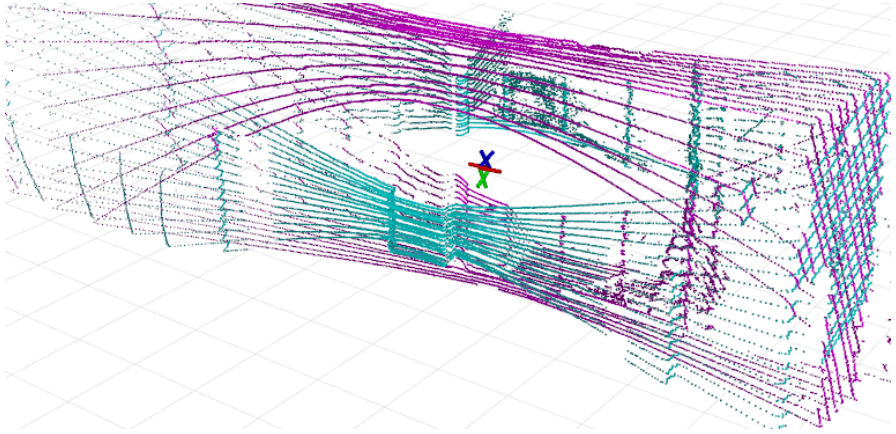
Figure 10. Two Velodyne LiDAR frames aligned into the single multiframe . This data association requires time synchronization and precise extrinsic calibration of laser